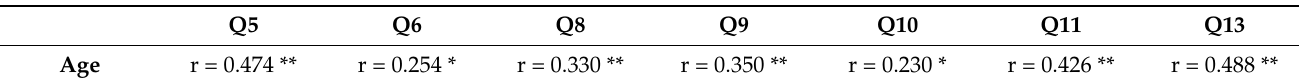
Table 5. Pearson’s correlation between age and influence of others on using VR (Q5, Q6); in using VR in the future (Q8); being good to do tourism (Q9); being adequate to know places and exercise safely (Q10, Q11); sharing the experience (Q13).